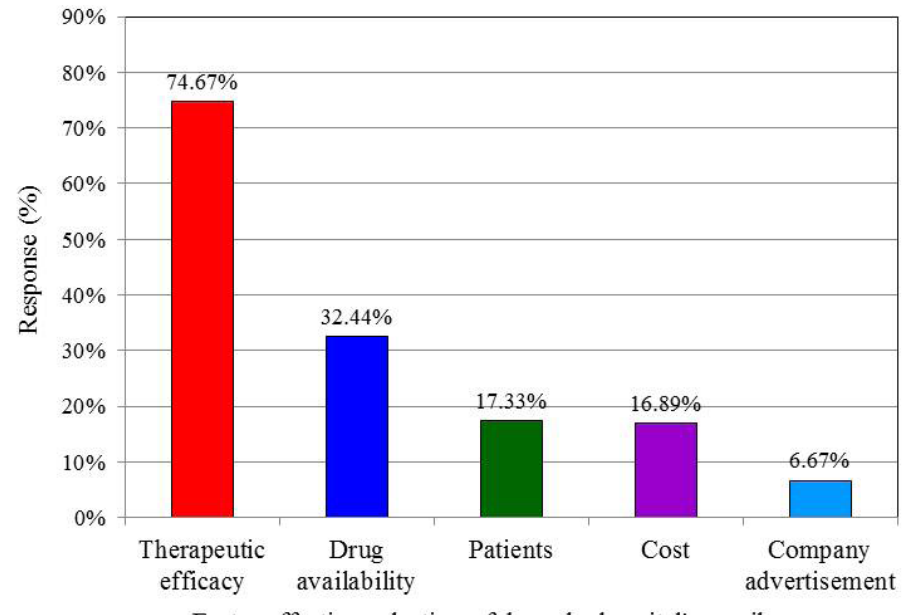
FIGURE 4 - Factors contributing to hospital prescribers’ selection of drugs.